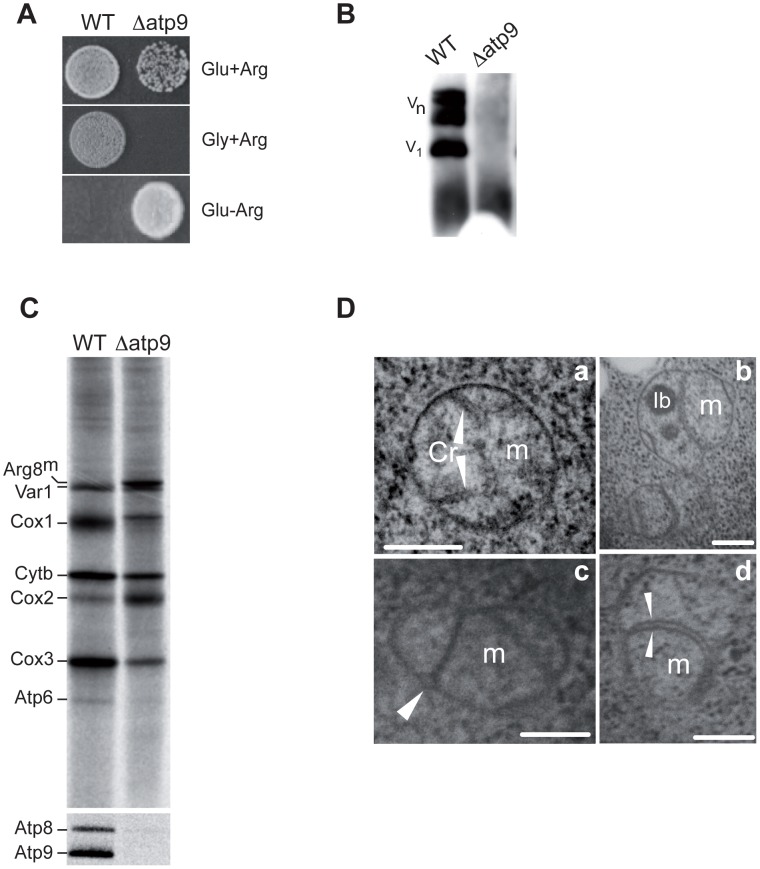
Deletion of the yeast mitochondrial ATP9 gene and resulting phenotypes.A) The mitochondrial ATP9 gene was deleted and replaced with ARG8m (see Figure S1 for details) in a wild-type strain lacking the nuclear ARG8 gene. As a result, the Δatp9 yeast grow on glucose (Glu) media lacking arginine (Arg) whereas the parental strain (WT) does not; in addition, Δatp9 yeast cannot grow on glycerol (Gly). B) ATP synthase levels in WT and Δatp9. Isolated mitochondria were separated by BN-PAGE and western blotted with antibodies against Atp4p; V
1 and V
n respectively indicate monomeric and oligomeric forms of ATP synthase. C) Pulse labelling of proteins translated in mitochondria. Total proteins were prepared from cells incubated in the presence of 35S methionine and cysteine as well as cycloheximide to inhibit cytosolic protein synthesis. Proteins (40,000 cpm per lane) were separated on 12% (Cox3p and Atp6p) or 17% (Atp9p and Atp8p) SDS-PAGE containing 6 M urea. D) Electron microscopy of WT (a) and Δatp9 (b–d) cells grown in galactose (80 nm-thin sections); m, mitochondria; Cr, cristae; Ib, inclusion bodies; arrowheads in (a) point to Cr, to outer mitochondrial membrane in (c), and to septae in (d); bars, 0.2 µm.